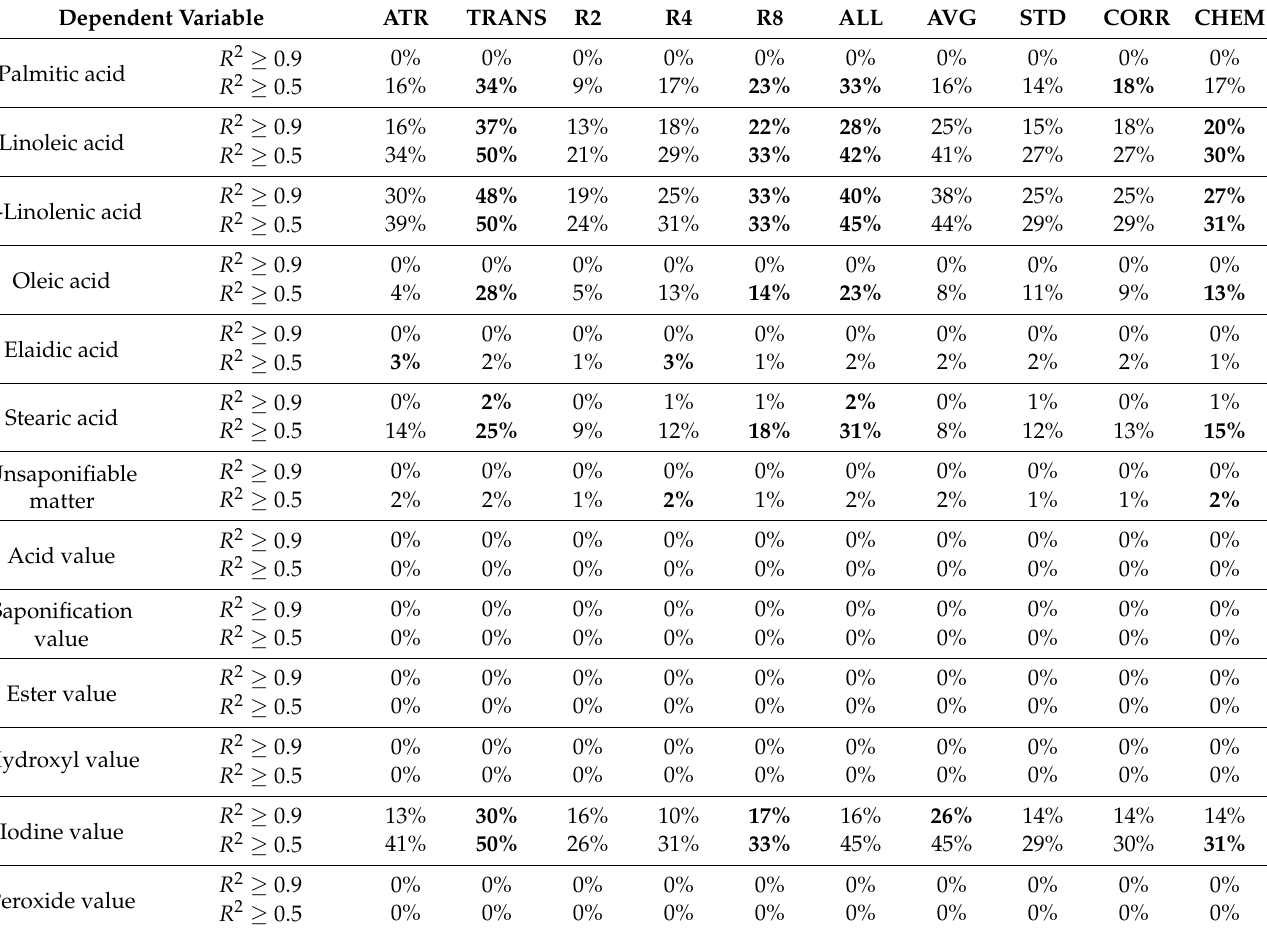
Table 2. Percent of models with R v 2 and R c 2 values that are both above 0.9 or 0.5 for individual predictive variables using different spectra recording techniques, resolutions, averaged or separate spectra, and variable selection techniques. Higher percentages are marked in